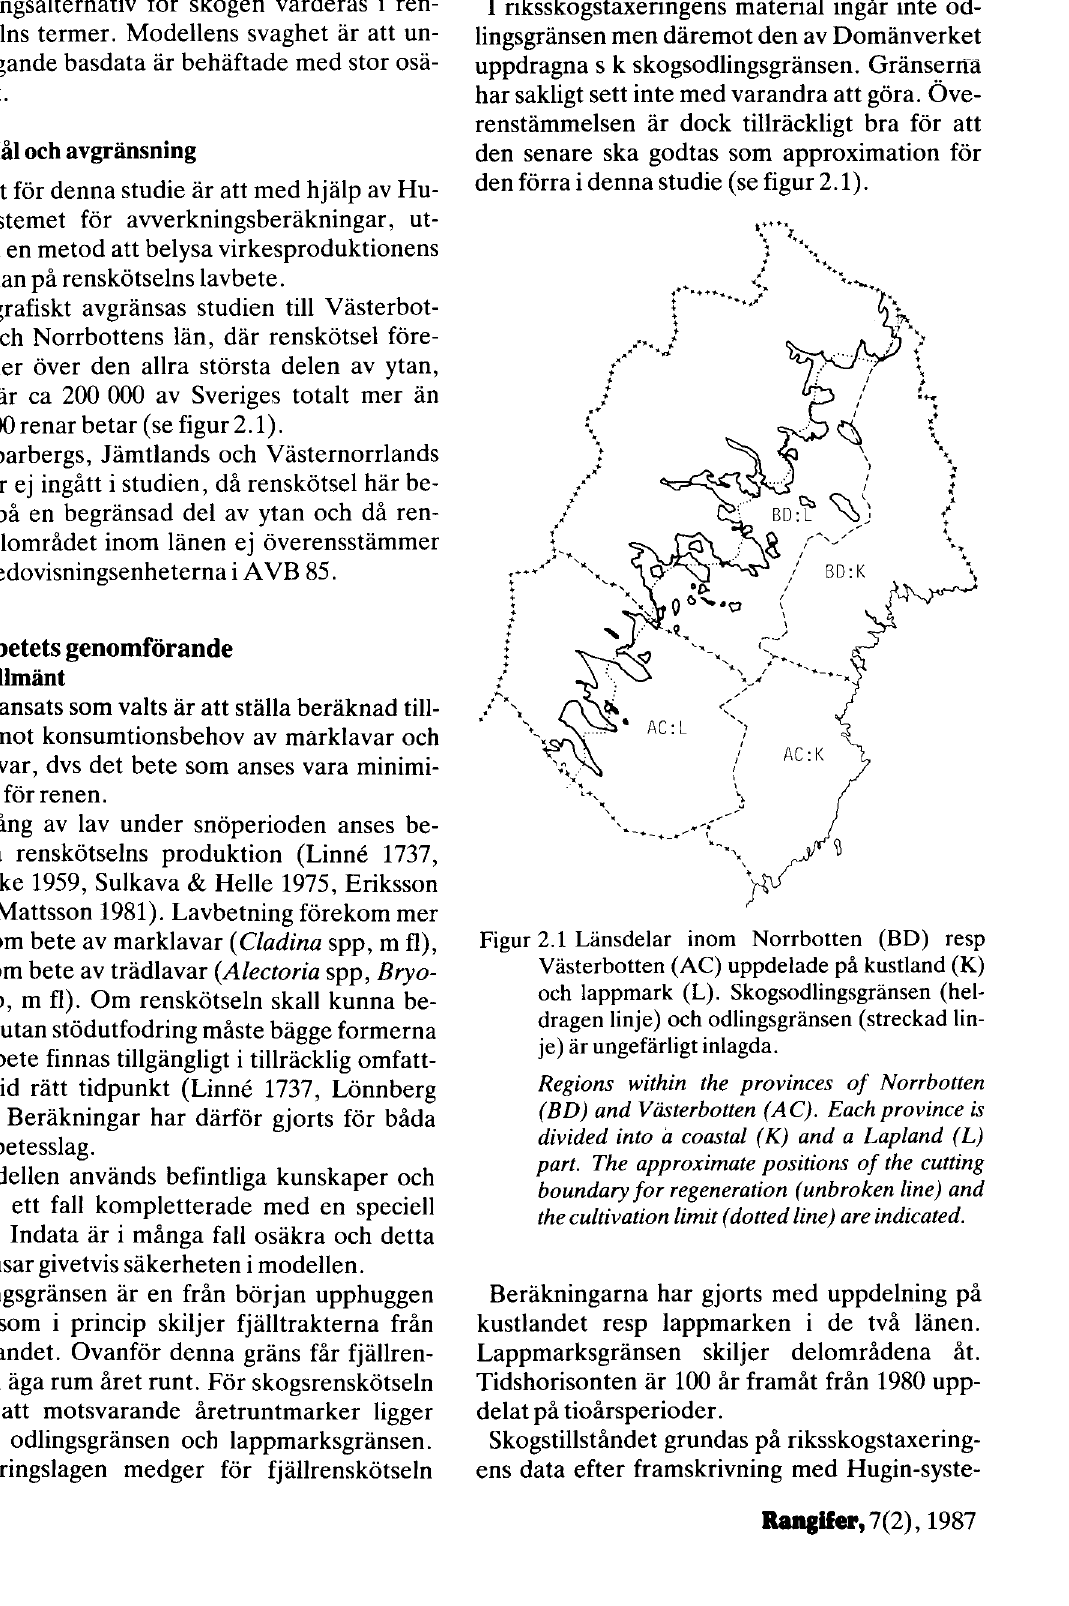
Figur 2.1 Lånsdelar inom Norrbotten (BD) resp Våsterbotten (AC) uppdelade på kustland (K) och lappmark (L). Skogsodlingsgrånsen (hel¬ dragen linje) och odlingsgrånsen (streckad lin je) år ungefårligt inlagda. Regions within the provinces of Norrbotten (BD) and Våsterbotten (AC). Each province is divided into a coastal (K) and a Lapland (L) part. The approximate positions of the cutting boundary for regeneration (unbroken line) and the cultivation limit (dotted line) are